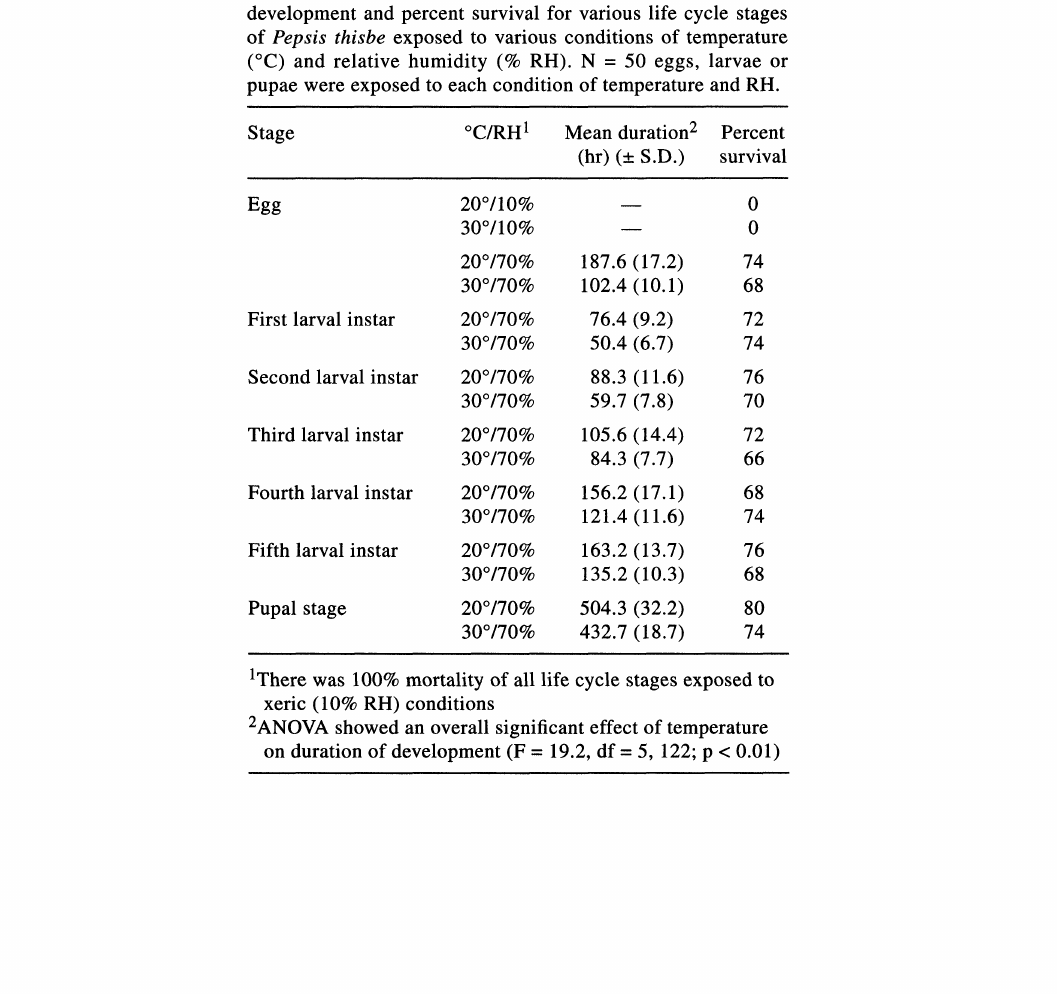
Table 2. Duration (hr) of embryonic and postembryonic development and percent survival for various life cycle stages of Pepsis thisbe exposed to various conditions of temperature (C) and relative humidity (% RH). N 50 eggs, larvae or pupae were exposed to each condition of temperature and